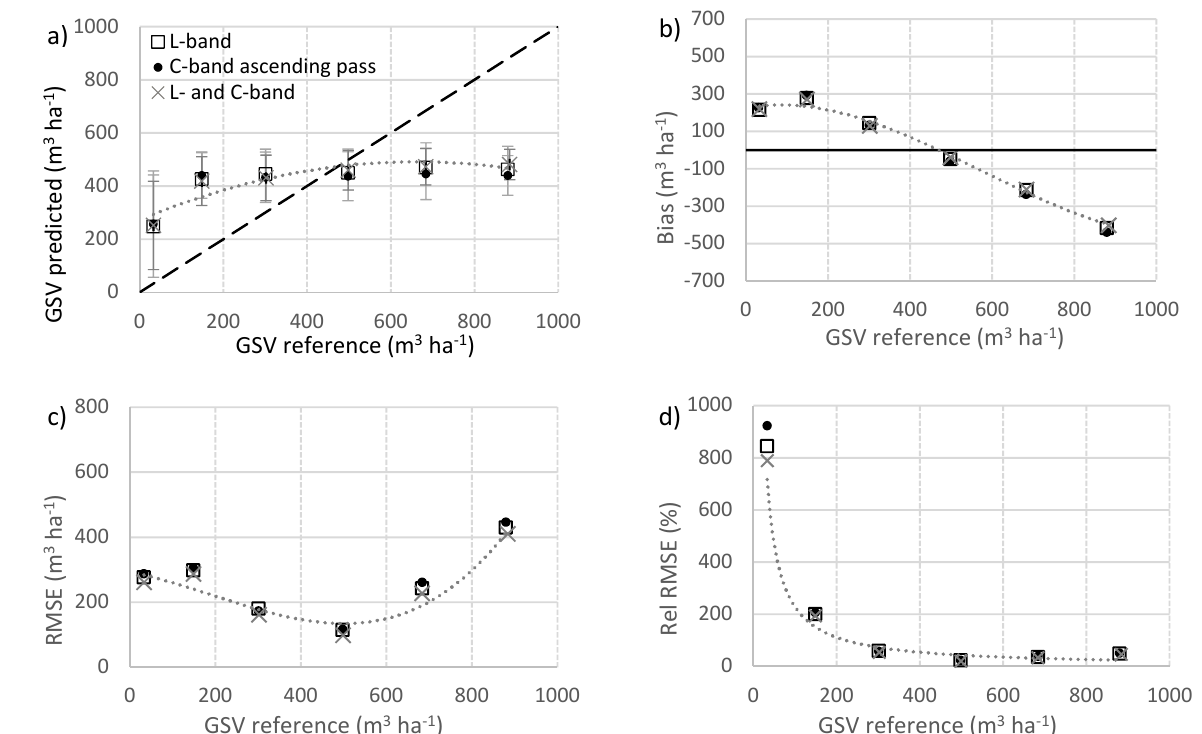
Figure 4. GSV retrieval metrics at pixel level for single polarization C- and L-band models, as well as the combined C- and L-band data: ( a ) GSV by range, error bars indicate standard deviation of the predicted values. ( b ) Distribution of bias, ( c ) root mean square error, and ( d ) relative root mean squared error. Dotted lines indicate fitting polynomial ( a – c ) and power ( d ) curve to the calculated points. The dashed line indicates identity line. Bins plotted at average bin value.